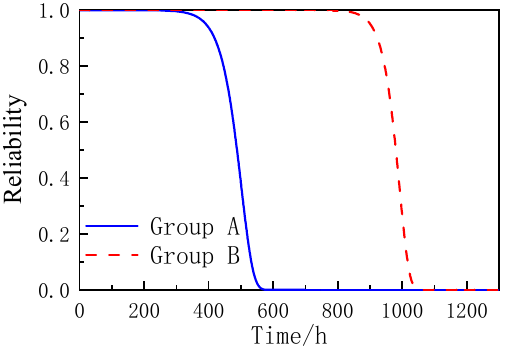
Figure 7. The reliability function diagram of MOCRC.